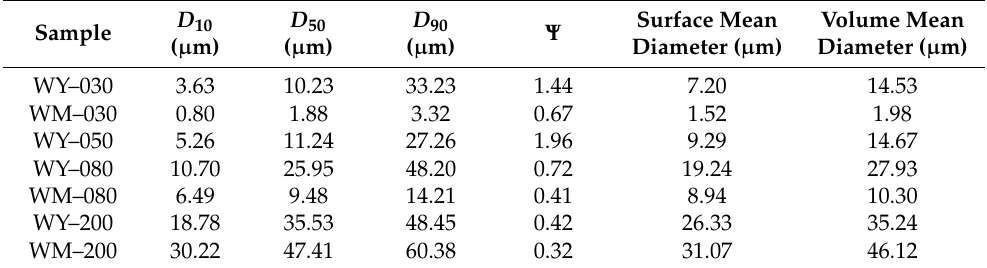
Figure 3. ( a ) Morphology and ( b ) particle size distribution of the WY–050 powder. Table 2. Particle size distribution of the commercial and jet-milled W powders.